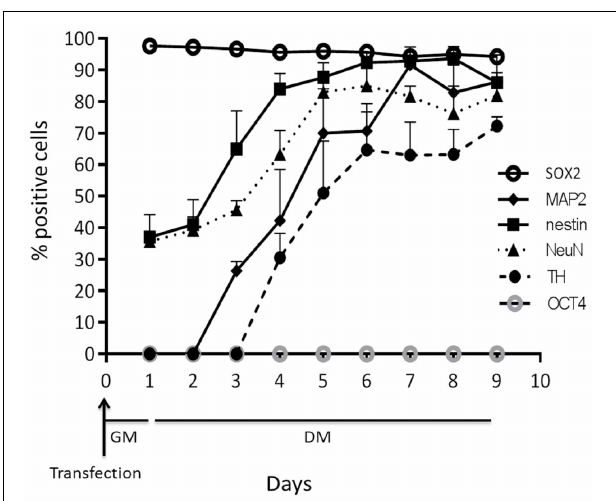
FIGURE 5 | The number of positive cells from MBs targeting OCT4, SOX2, Nestin, NeuN, MAP2, and TH over time. Results from three independent experiments are presented as mean ± standard error of the mean (s.e.m).